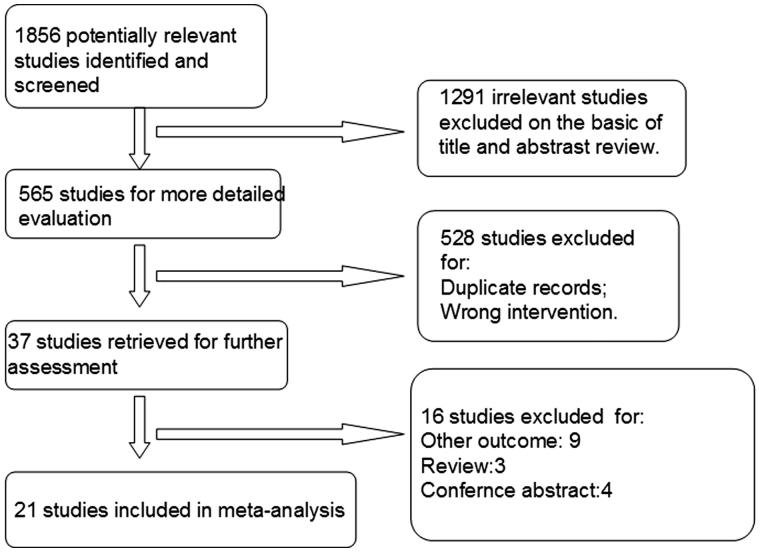
Flow diagram of study selection: far infrared therapy for hemodialysis patients.